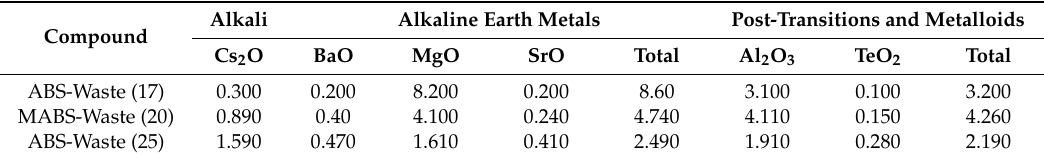
Table 3. Chemical composition of the studied glasses (waste components: alkali, alkaline, post-transitions, and metalloids).